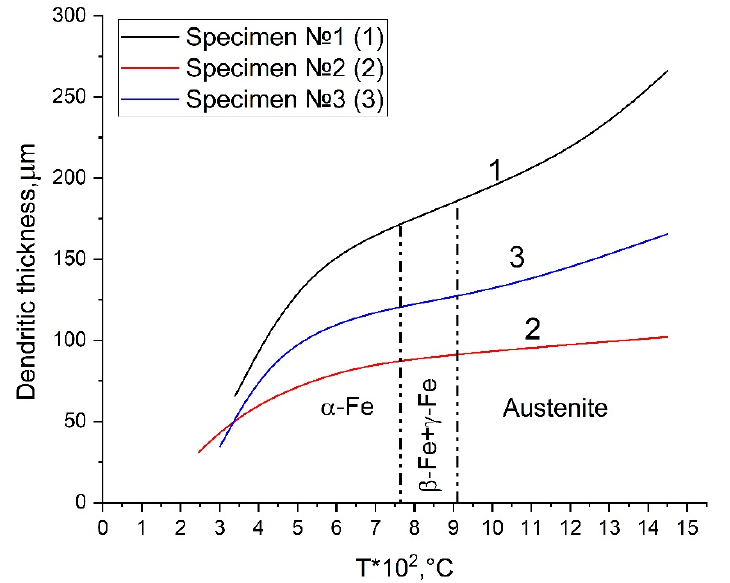
Figure 10. Dependences of the dendritic thickness from temperature in the central part of the cross-section of the specimens.